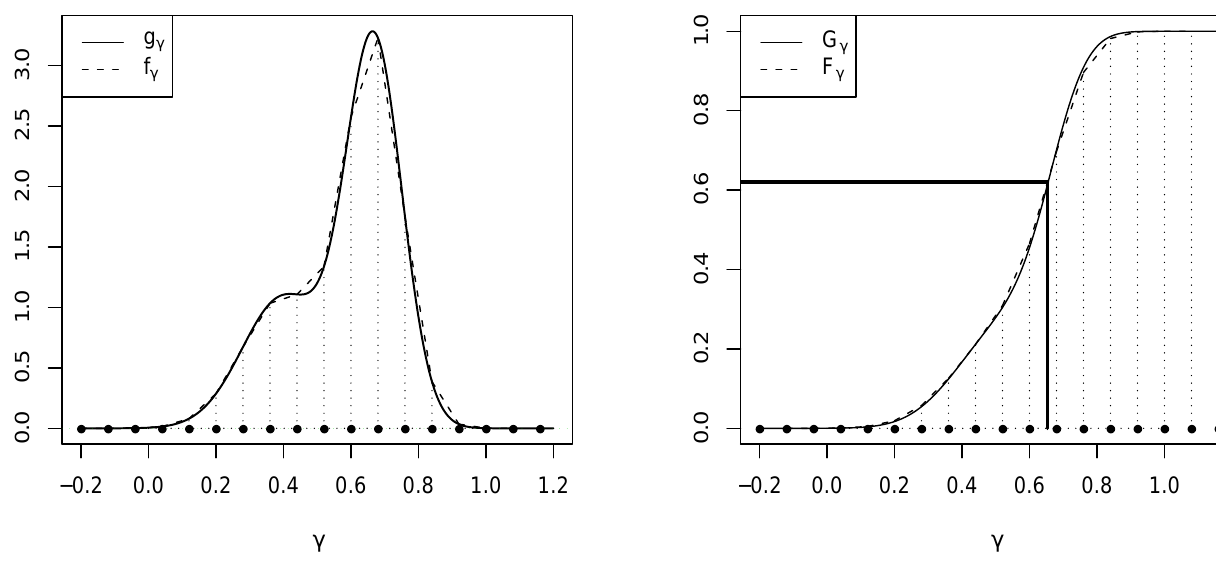
Figure 3. The conditional density g integration over a grid of points (left). An approximation F